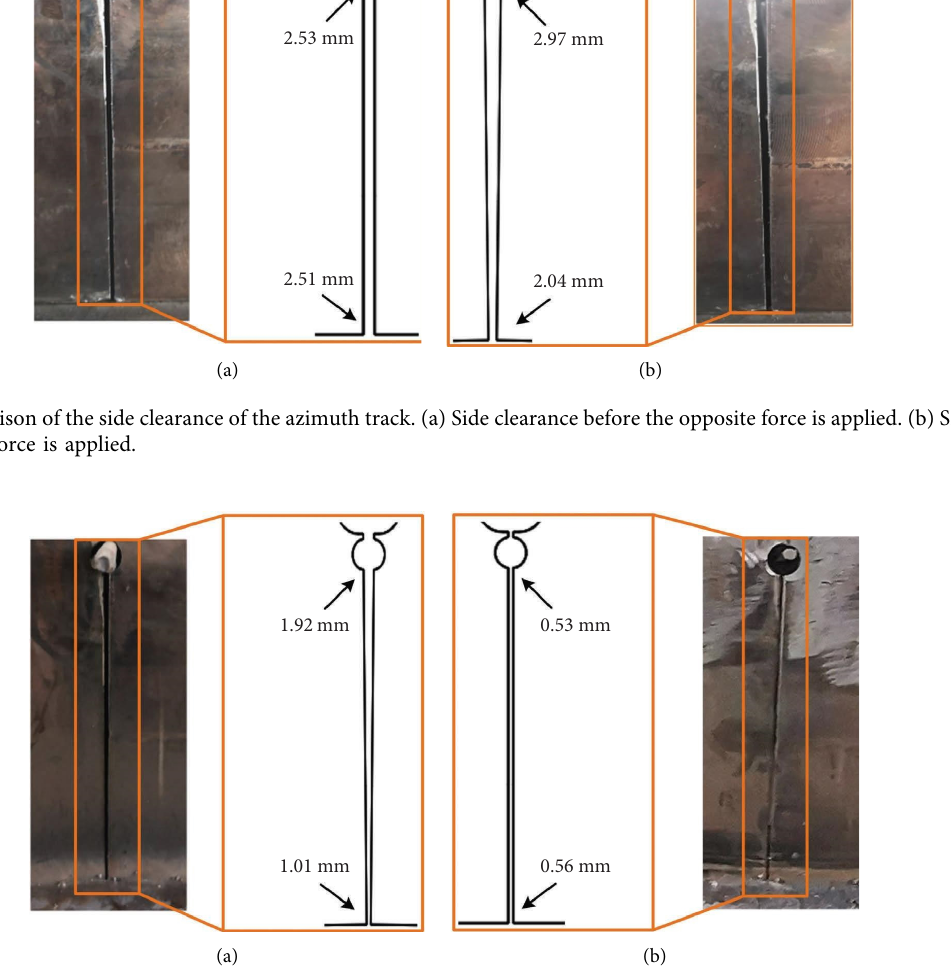
Figure 11: Comparison of the side clearance of the azimuth track. (a) Side clearance before welding. (b) Side clearance after